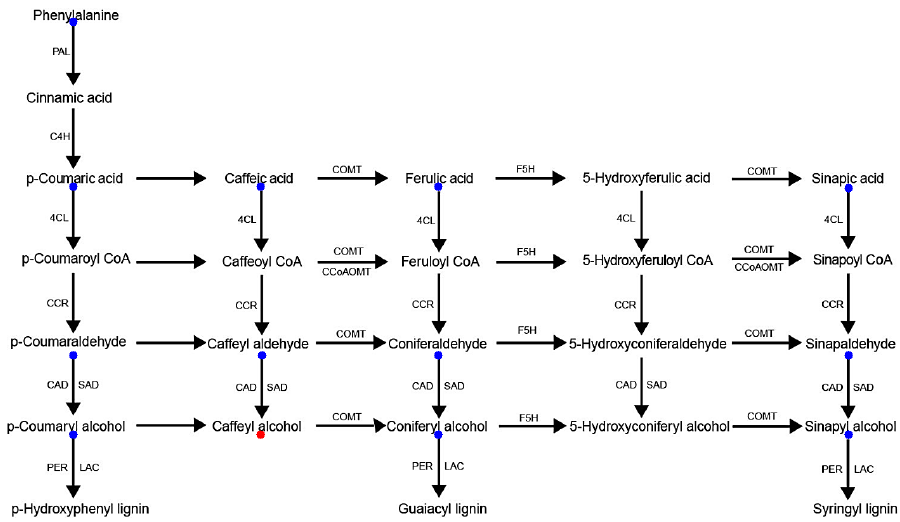
Figure 6. Lignin synthesis pathway-related metabolites differentially accumulated between wild-type Pingtangheinuo rice and brittle stem mutant osbc17 . Metabolites that were not significantly changed or significantly up-regulated in the brittle stem mutant are indicated by blue and red, re- spectively.